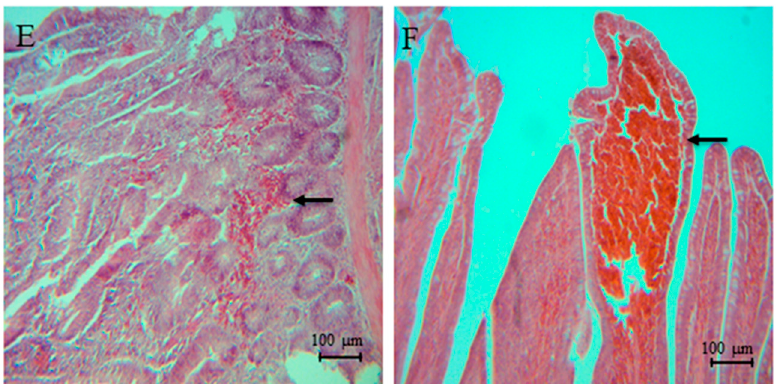
Figure 2. Histopathological lesions in duodenum of broilers challenged with Salmonella Typhimurium and Clostridium perfringens . ( A ) Epithelium without apparent lesions (4 × ), ( B ) calciform cells hyperplasia (10 × ), ( C ) villi without apparent lesions (10 × ), ( D ) lymphocyte infiltration (40 × ), ( E ) hemorrhagic villi (10 × ), and ( F ) congested villi (10 × ).